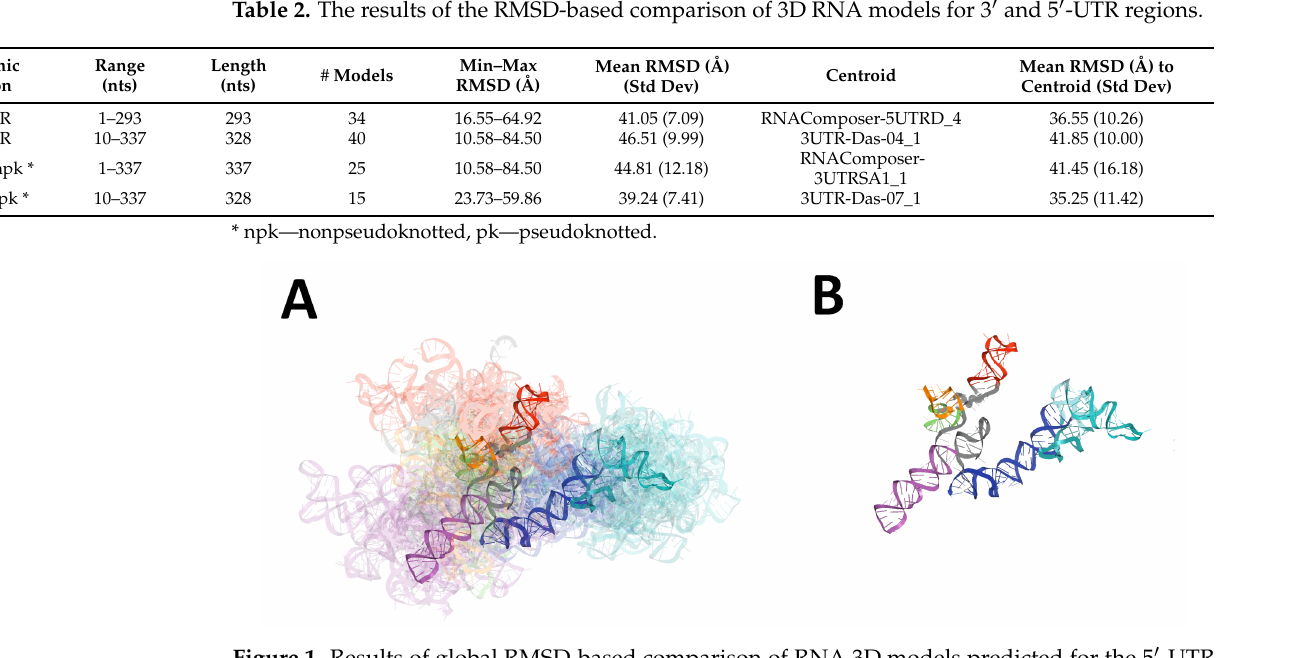
Figure 1. Results of global RMSD-based comparison of RNA 3D models predicted for the 5 (cid:48) -UTR region of SARS-CoV-2. Domains: SL1 (red), SL2 (green), SL3 (orange), SL4 (magenta), SL4.5 (light purple), SL5abc (cyan and teal), SL5 stem (blue). The centroid of each ensemble is solid, other members are transparent. ( A ) The ensemble of 3D RNA structures, and ( B ) its